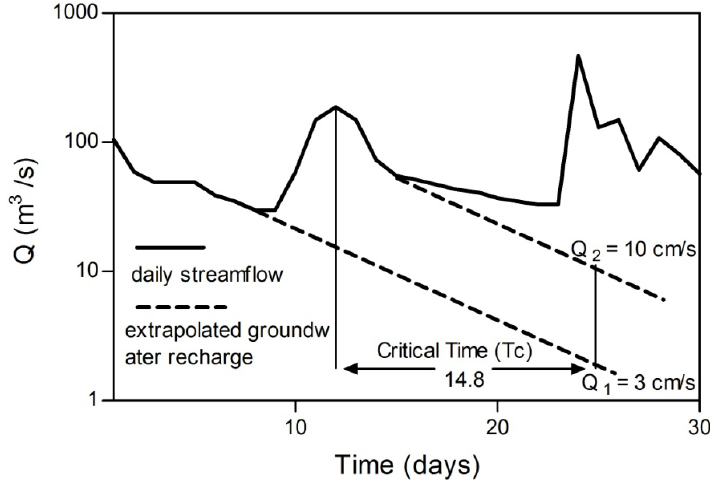
Figure 5. Procedure of the displacement recession curve method.